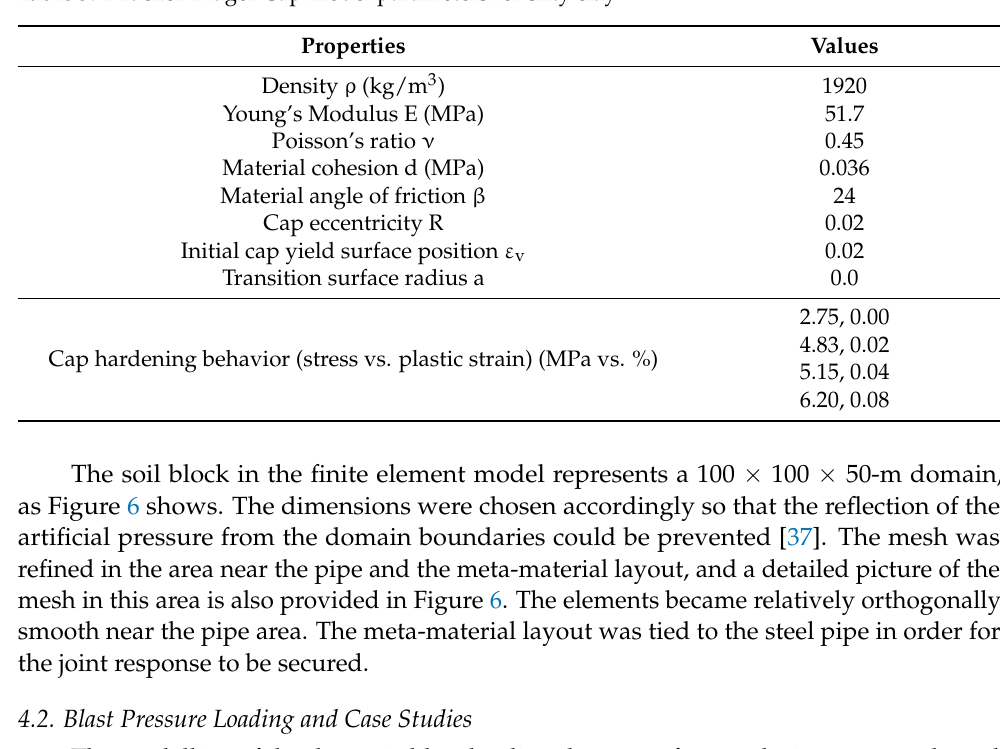
Table 3. Drucker-Prager Cap model parameters for silty